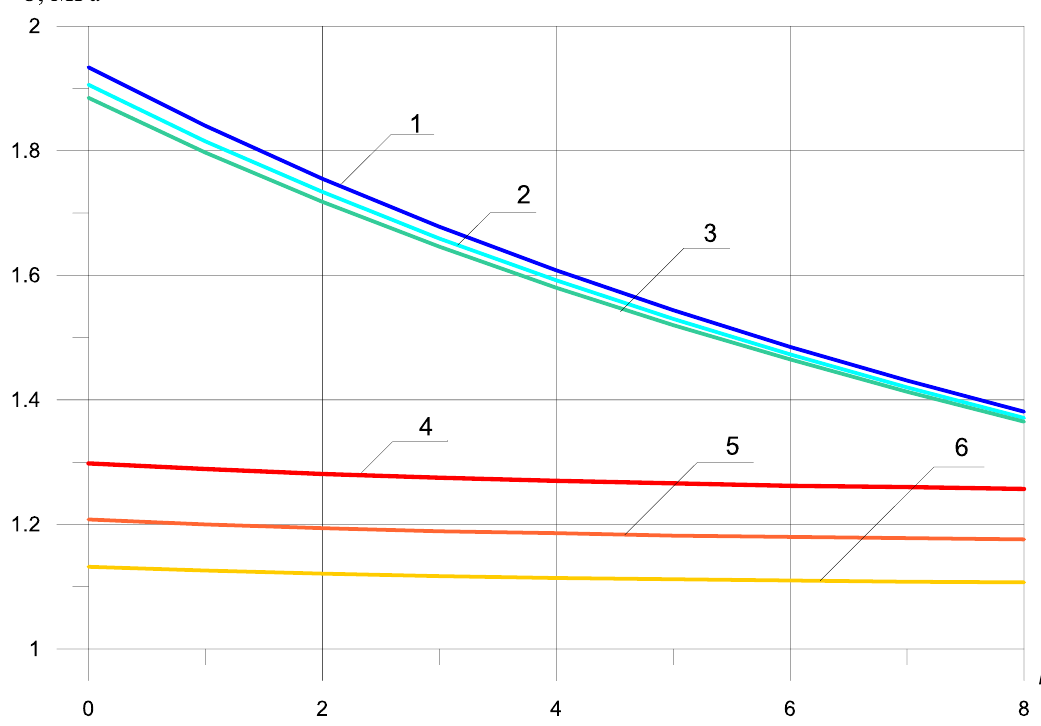
Figure 3. Dynamic stresses with bimodularity depending on the number of bars in the zone under tension, excluding the beam mass: (1) σ t at n c = 0; (2) σ t at n c = 2; (3) σ t at n c = 4; (4) σ c at n c = 0; (5) σ c at n c = 2; (6) σ c at n c =